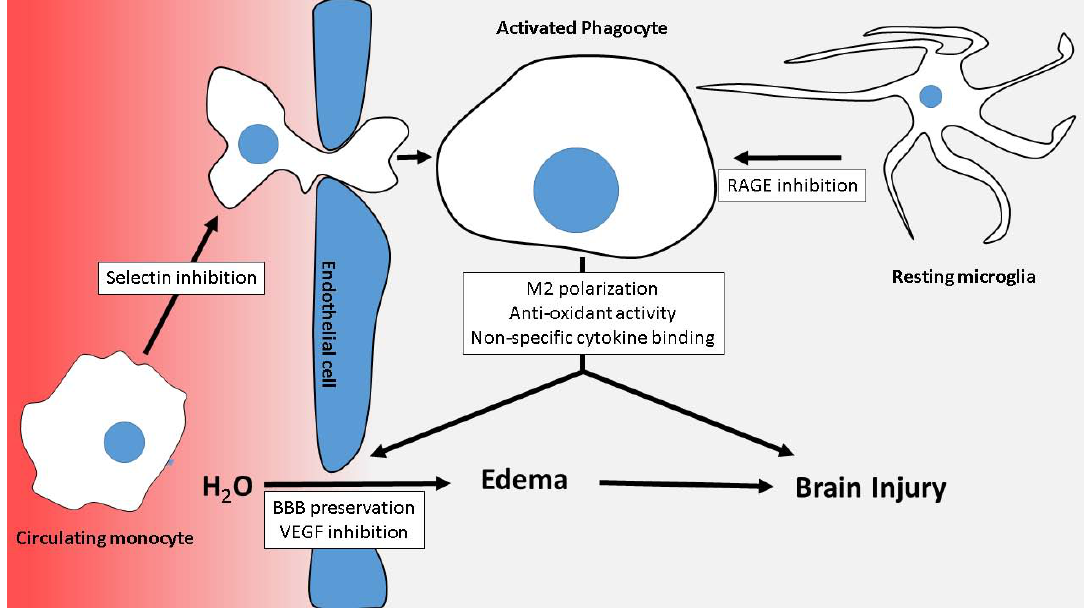
Figure 2. Summary of heparin’s modes of action. Several confluent processes combine to injure the brain including extravasation of circulating cells into the brain parenchyma, activation of microglia, production of harmful molecules and cytokines by activated phagocytes, and blood-brain barrier breakdown with subsequent vasogenic edema formation. Heparin antagonizes these processes, with heparin’s mechanisms of action indicated in the white